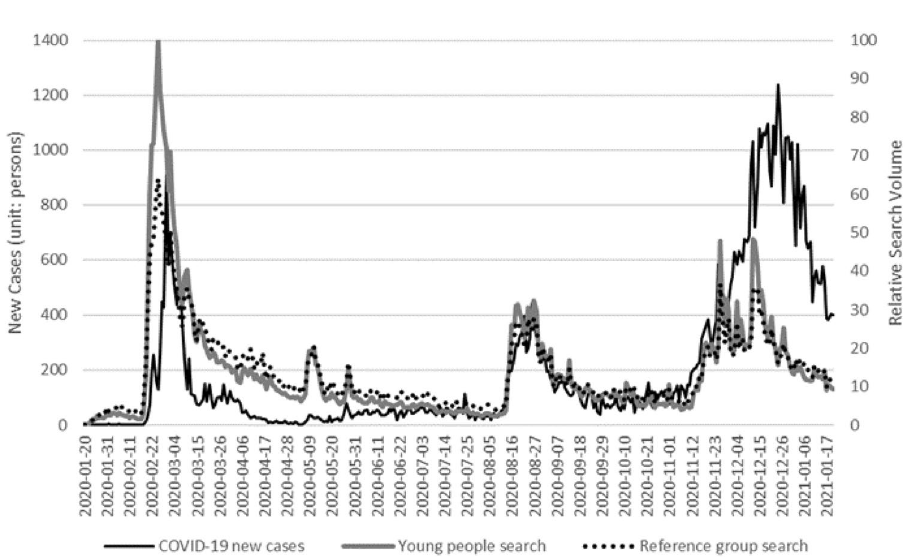
Figure 2. Comparison of search trends between young people and the reference group.